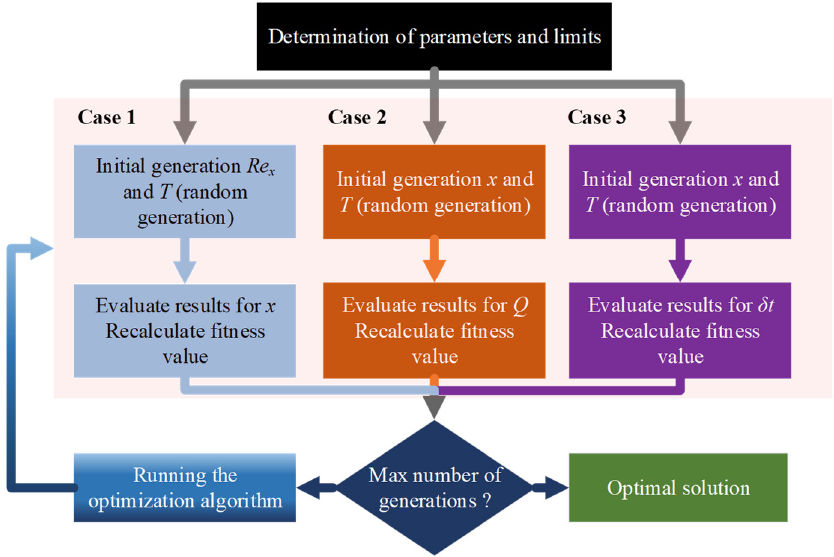
Figure 6. Case flows of optimization.